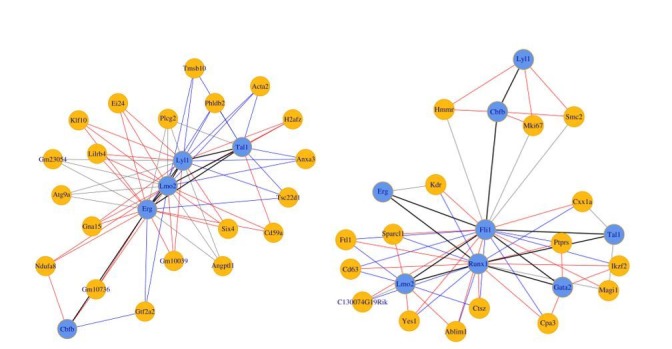
(Left) 8TFs network in our sc-RNA-Seq data.(Right) 8TFs network in Pereira sc-RNA-Seq data.